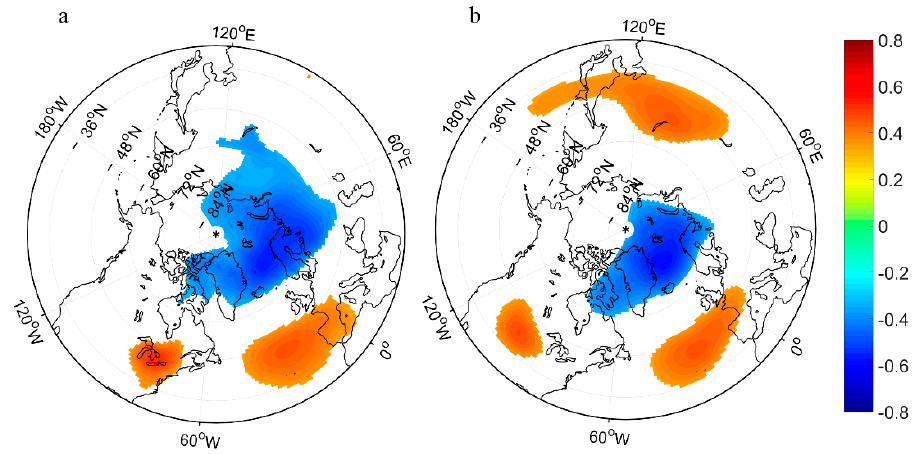
Figure 7. ( a ) The correlation coefficient distribution between the Barents–Karas sea ice concentration index and winter sea level pressure in the Northern Hemisphere; ( b ) the correlation coefficient distribution between Barents–Karas sea ice concentration index and winter 500 hpa geopotential height in the Northern Hemisphere. The colored regions passed the t -test with a confidence level of 95%. All of the series have been detrended.